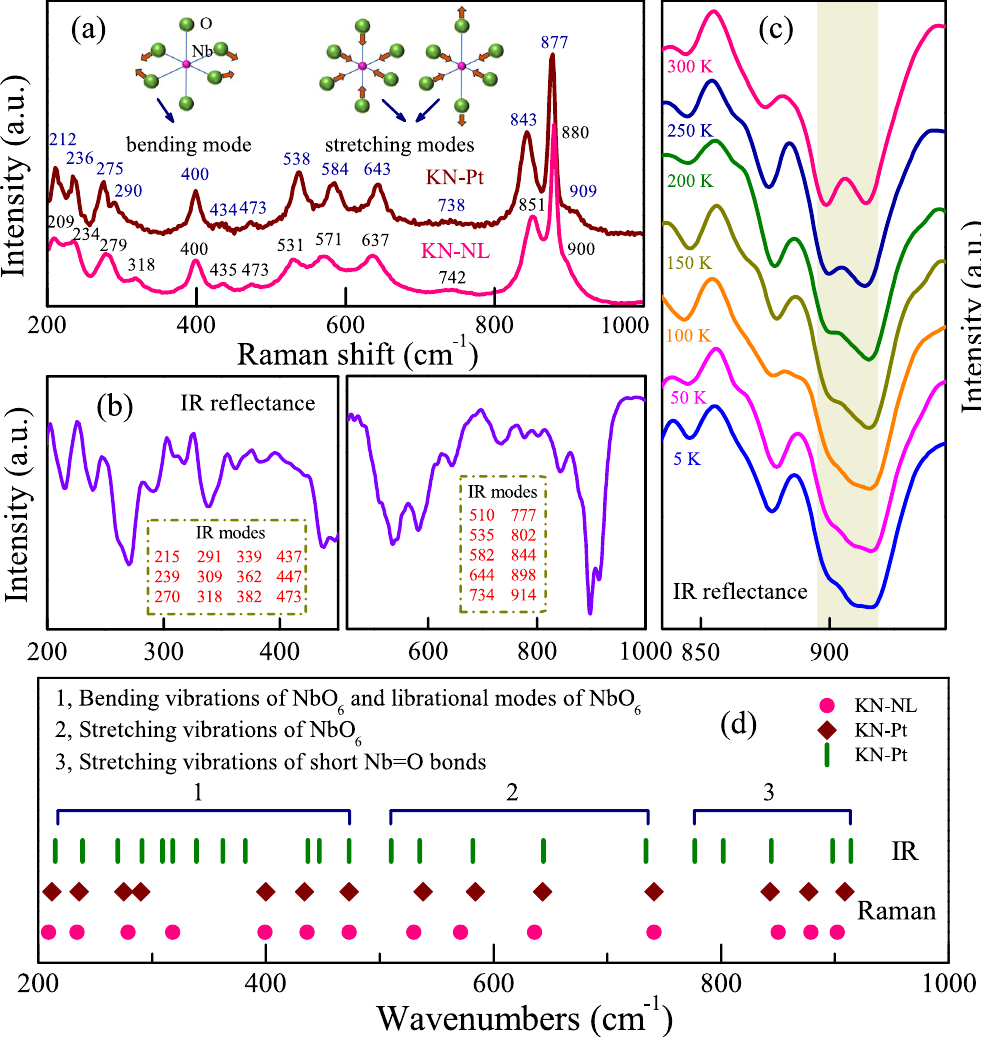
Figure 4. ( a ) Raman spectra of KN-Pt and KN-NL. The insets show the schematic illustrations of bending and stretching vibrational modes of NbO 6 octahedra. ( b ) IR reflectance spectra of KN-Pt at room temperature. ( c ) Temperature dependent IR reflectance spectra of KN-Pt. The rectangular area corresponds to the obvious changes of IR modes. ( d ) Comparison of Raman and IR active modes for KN-NL and KN-Pt with the proposed